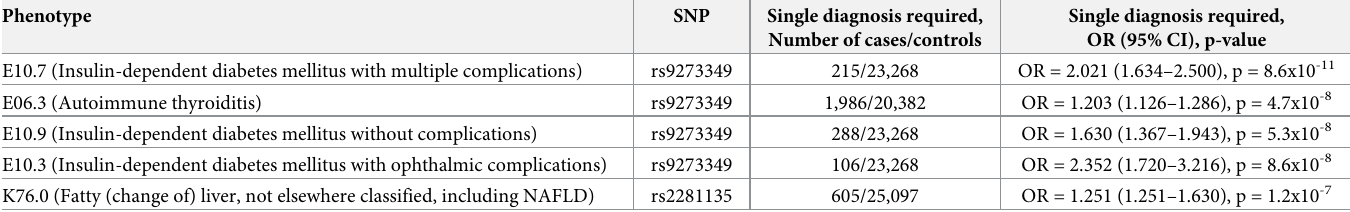
Table 7. Results of the PheWAS using exact ICD-10 diagnosis codes and passing the PheWAS significance threshold. Phenotype SNP Single diagnosis required,